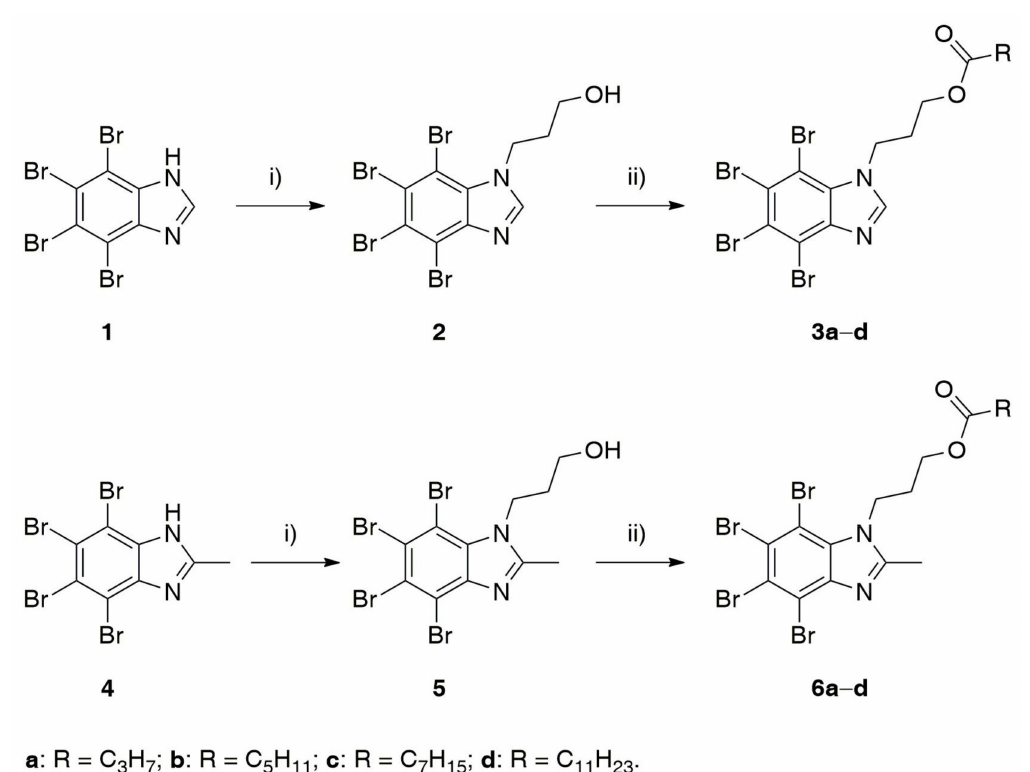
Figure 2. Synthesis of the 3-(4,5,6,7-tetrabromo-1 H -benzimidazol-1-yl)propyl esters ( 3a – d ) and 3-(4,5,6,7-tetrabromo-2- methyl-1 H -benzimidazol-1-yl)propyl esters ( 6a – d ): (i) 3-bromopropan-1-ol (8 equiv), K 2 CO 3 (2 equiv), CH 3 CN, reflux, 96 h; (ii) acyl chloride (RCOCl, 2 equiv), DMAP (0.5 equiv), DCM, 30 ◦ C, 24 h or vinyl ester [RC(O)OCH=CH 2 , 2 equiv], Novozym 435 (10% w / w ), DCM, 30 ◦ C, 24